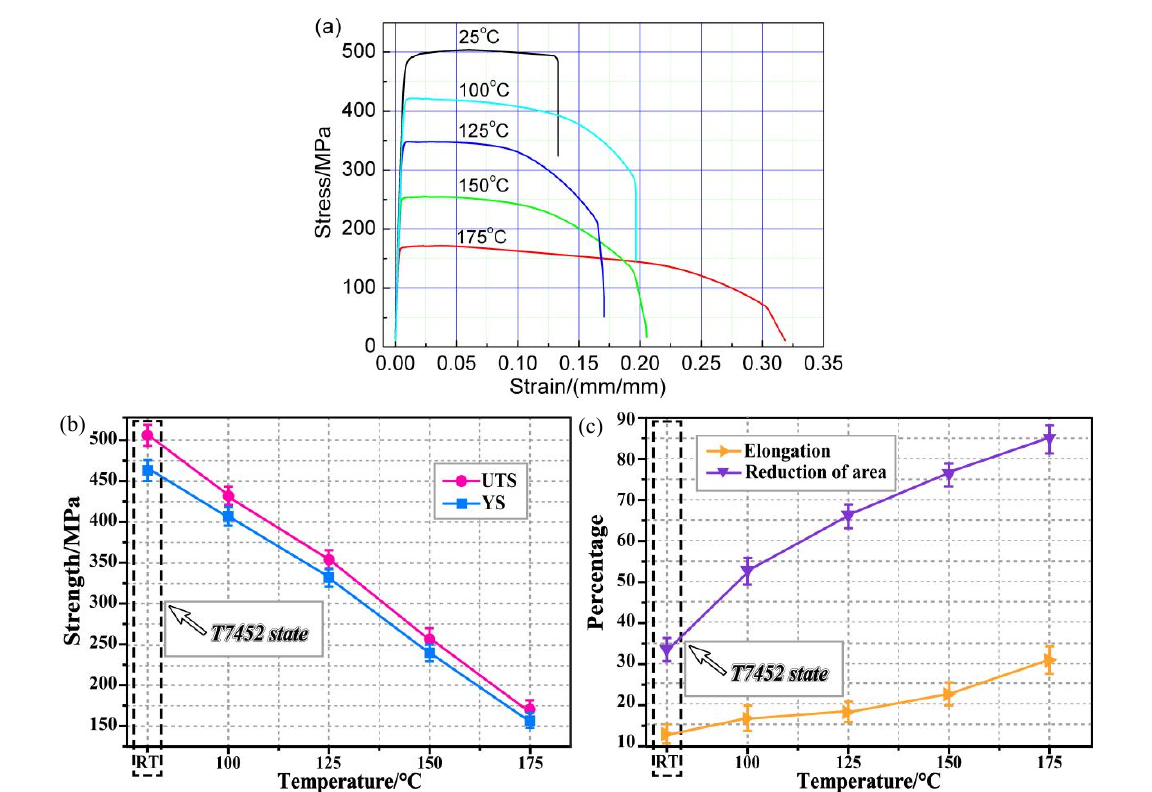
Figure 3. ( a ) Mechanical properties of the 7085 Al alloy after heat treatment at different temperatures, ( b ) tensile strength, ( c ) elongation and reduction of area.